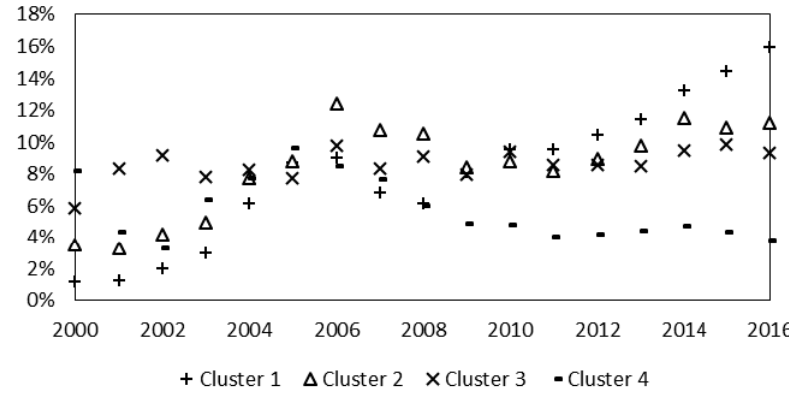
Figure 5. Yearly trends in publishing per cluster. Clusters 1–4: robots as social partners, human factors and ergonomics in human robot interaction, robotics for child development and swarm robotics.